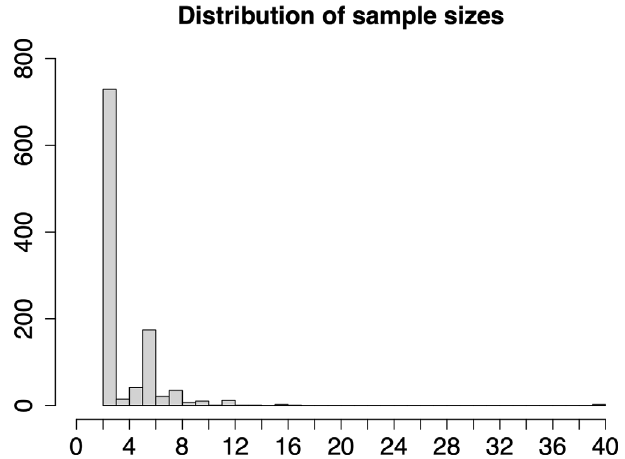
Figure 3. Histogram showing the frequency ( Y axis) distribu- tions of sample size ( X axis) in immunoblotting experimental conditions (actual study size: n = 1054). Only experimental conditions with clearly disclosed sample sizes were included